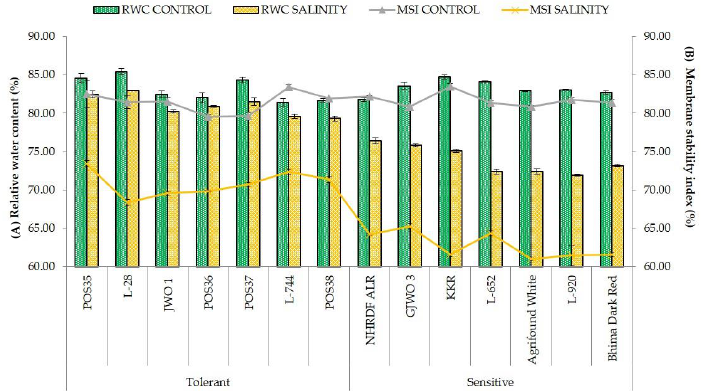
Figure 1. Changes in relative water content (%) (A); and membrane stability index (%) (B) of onion accessions under control and salinity stress.